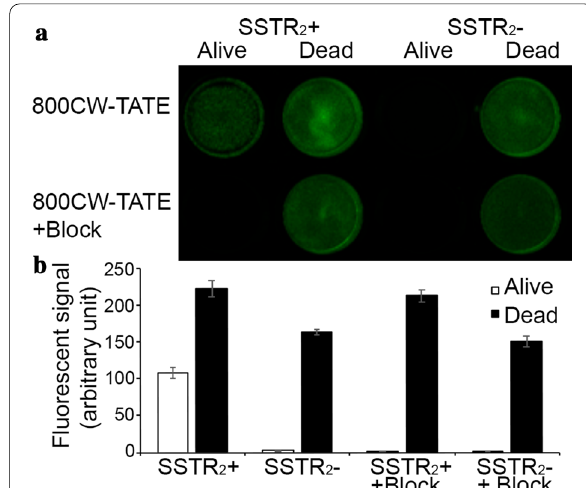
Fig. 2 NIR-fluorescence imaging of alive or dead U2OS cells with and without SSTR 2 -expression, exposed to 800CW-TATE (10 nM in culturing medium). Blocking is performed by co-incubation with DOTA-TATE (10 µM). Fluorescent signal U2OS cells transfected with quantified SD, n 12. SSTR 2 + = ± = SSTR 2 ; SSTR 2 - wild-type U2OS cells without SSTR 2 -expression; = 800CW-TATE Ac-Lys 0 (IRDye800CW)-Tyr 3 -octreotate; = DOTA-TATE DOTA 0 -Tyr 3 =